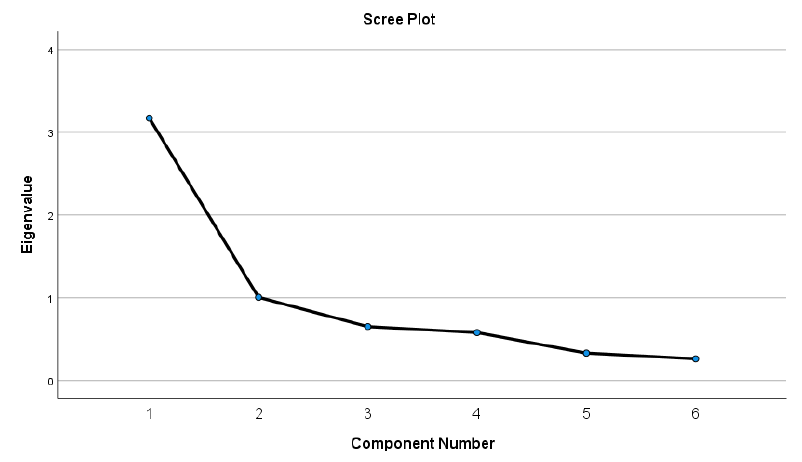
(Figure 2) confirmed the two-factor structure of the 6-item FAS.